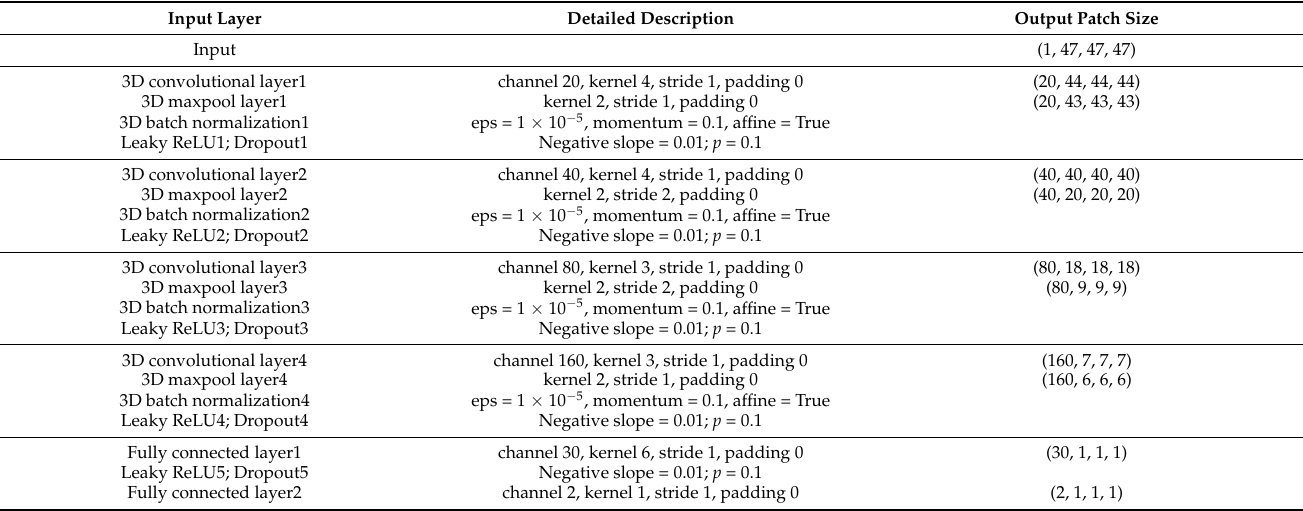
Table 3. The parameter settings of FCN model.